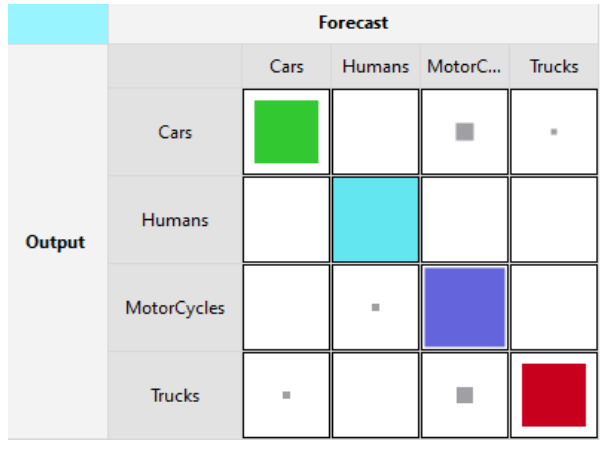
Figure 4. Radar testing forecast [3].